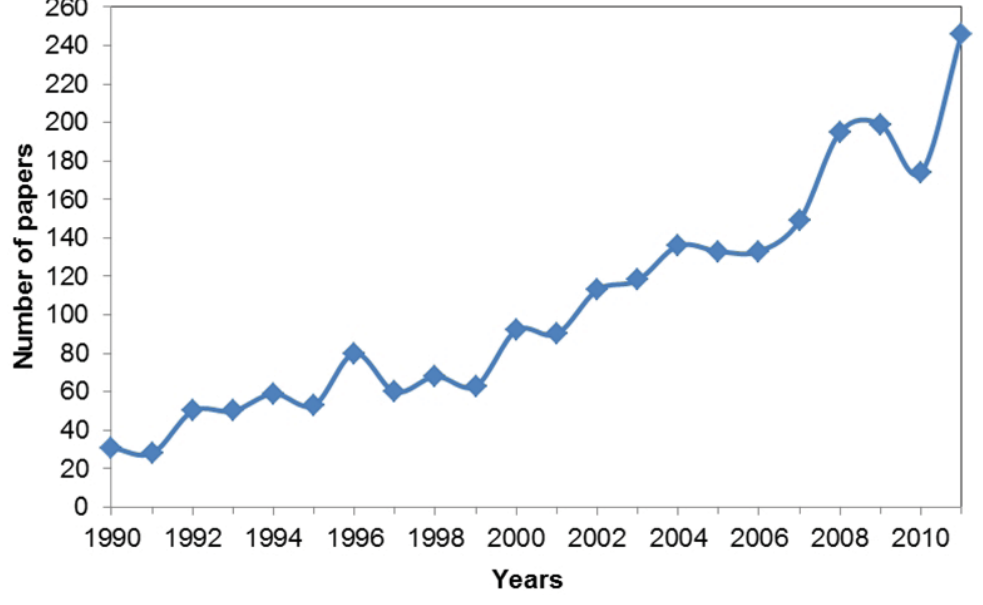
Figure 3. The total number of reviewed articles published from 1990 to 2011. The 242 articles published in 2012 were not included in this analysis as the data collection period did not account for the entire year.